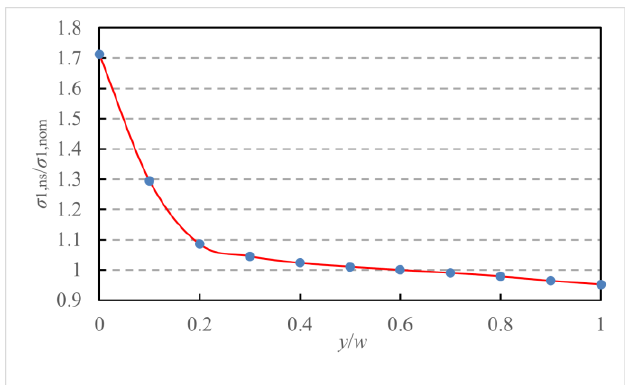
Figure 4. The distribution of the first principle stress calculated numerically at the notched section, under the maximum fatigue load, P max , for specimen B1.